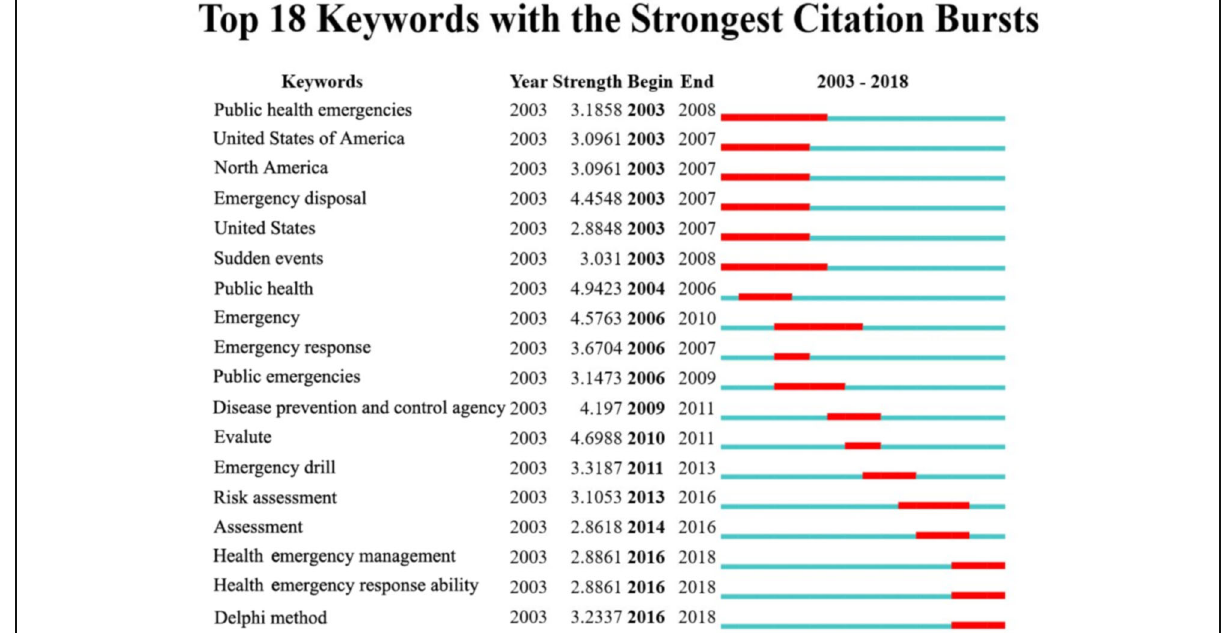
Fig. 10 Keywords with the strongest citation bursts of Chinese database. The strength represents the degree of the burst. The begin and end represent the boundaries of the time period of the burst. The blue line is the time interval, the red line segment is the duration of the burst for one keyword